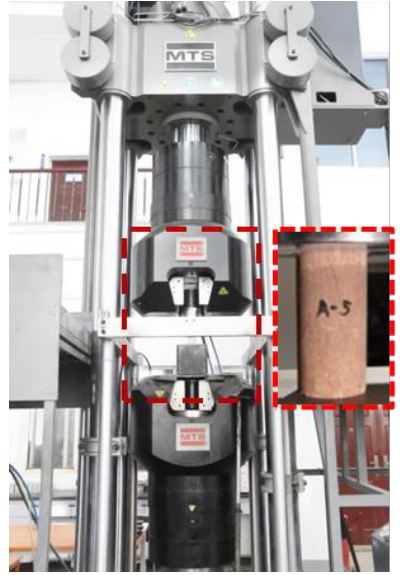
Figure 3. Fatigue machine and